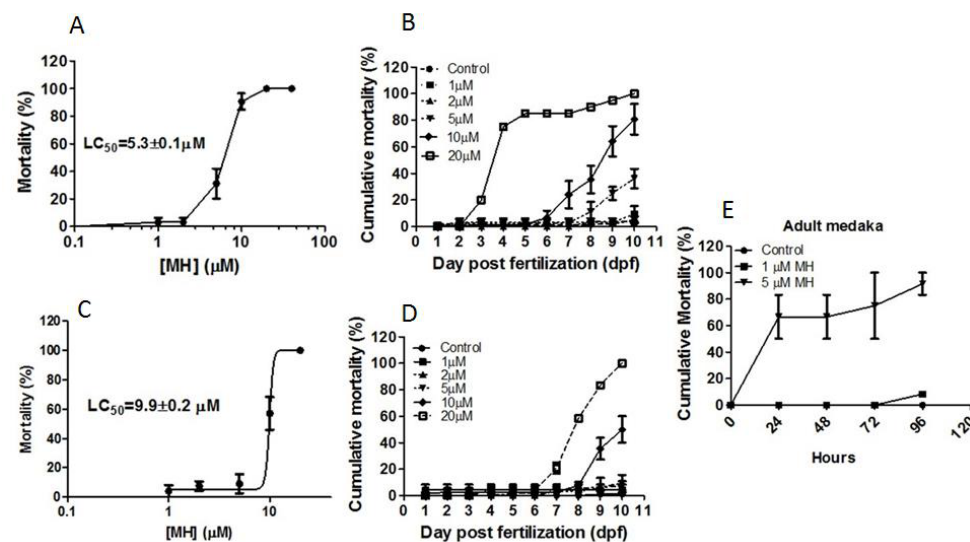
Figure 1. Cumulative mortality of medaka embryos. Embryos were exposed to 1, 2, 5, 10, and 20 µ M 4- O -Methylhonokiol (MH) for 0 – 6 days post fertilization (dpf) ( A and B ) or 2 – 6 dpf ( C and D ). ( A ) Embryos were treated with MH for six days from hour 5, and the LC 50 was calculated based on mortality observed at 10 dpf. ( B ) Cumulative mortality of all embryos until 10 dpf treated with various concentrations of MH for 0 – 6 dpf. ( C ) Embryos were treated with MH for four days from 2 dpf and the LC 50 was calculated based on mortality observed at 10 dpf. ( D ) Cumulative mortality until 10 dpf of all embryos treated with various concentrations of MH for 2 – 6 dpf. The LC 50 was calculated by log transformed data using nonlinear regression (curve-fit) (GraphPad Prism). Each value represents mean ± SEM ( n = 12, replicated five times). ( E ) The relationship between MH concentration and mean adult medaka mortality. Eighteen male medakas were randomly divided into three groups ( n = 6). They were exposed to 1 or 5 μ M MH, and monitored for 96 h. Controls were exposed to 0.02% DMSO.